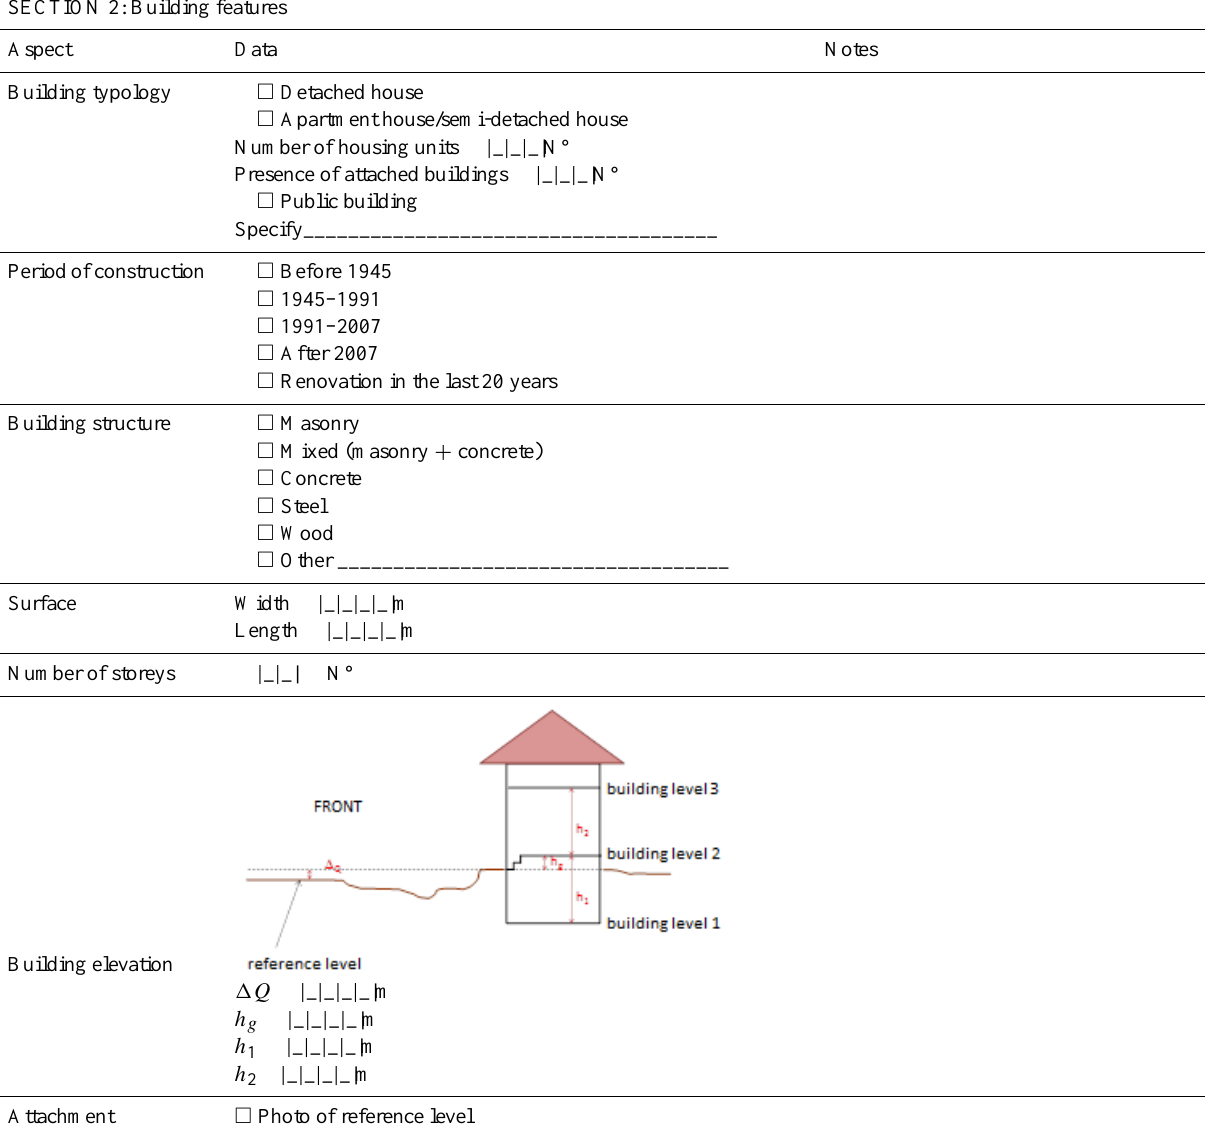
Table 3. Extract from the forms.